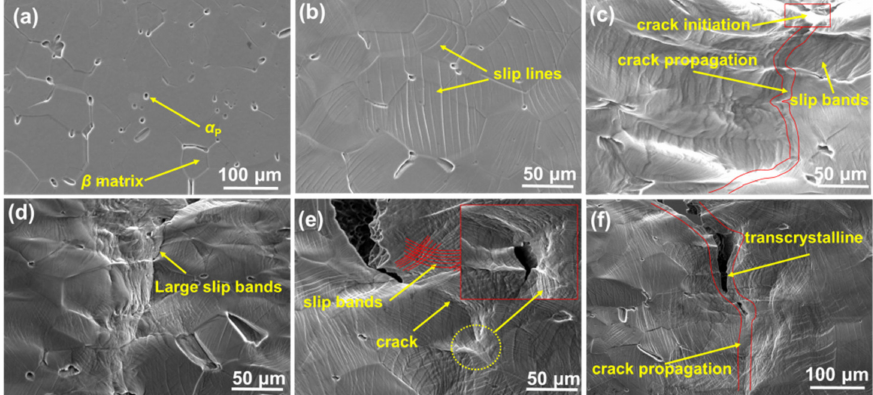
Figure 10. In situ tensile testing process of HT alloy: ( a ) ε = 0, ( b ) ε = 0.10, ( c ) ε = 0.26, ( d ) ε = 0.34, ( e ) ε = 0.53, ( f ) ε =